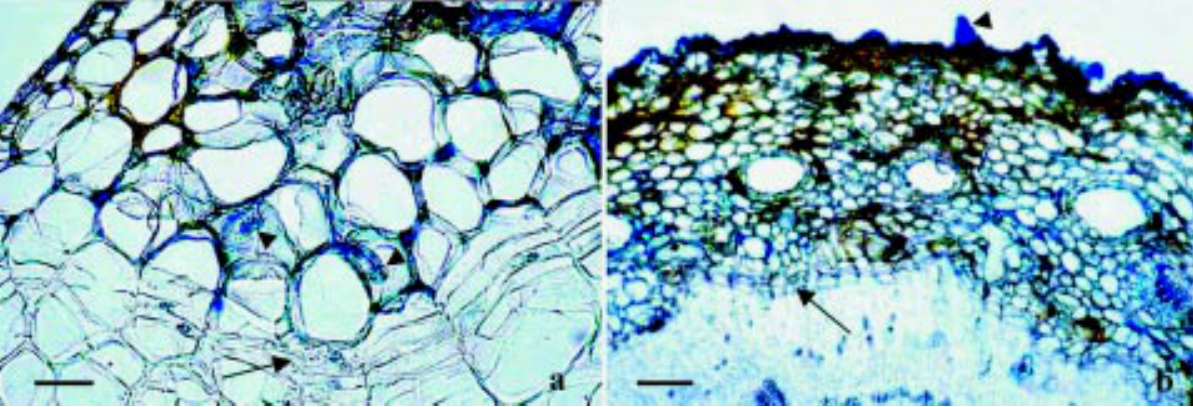
Fig. 2. a, b. Transverse sections of Pinus shoots, cryo-cut and stained with cotton blue, with necroses on a, P. nigra subsp. laricio and b, P. pinea, after inoculation with Melampsora larici-tremulae from a, Baiardo and b, Vallombro- sa; a, small necrosis in the cortical parenchyma and rust haustoria with encasement in the necrotic parenchyma cells (arrow-heads); incomplete necrophylactic periderm bordering the necrotic tissue (arrow); b, necrosis extending tangentially and radially for some distance in the cortical parenchyma colonised by rust mycelium, aborted subcu- ticular spermogonia (arrow-head) and continuous necrophylactic periderm delimiting the necrotic tissue (arrow). Scale bars: a, 50 m m; b, 100 m